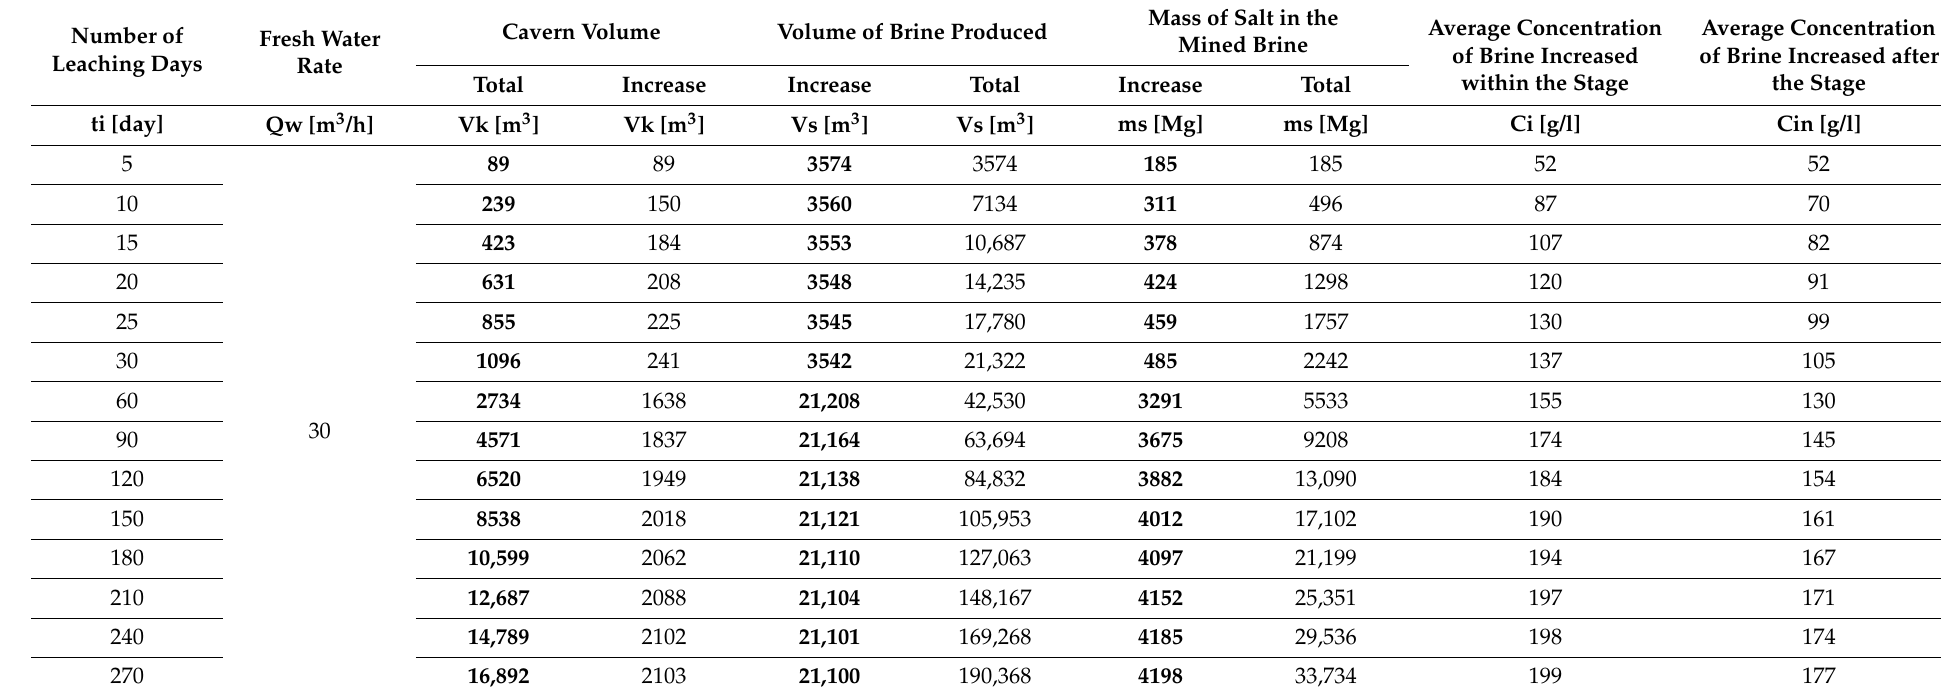
Table 4. Development of the sump leaching process directly from the borehole—Stage I/Scenario 1 (S